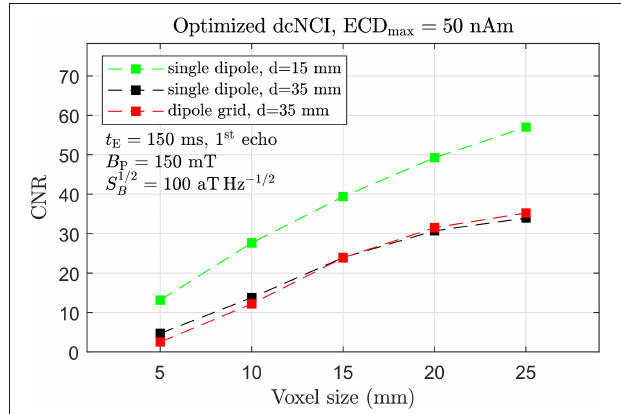
FIGURE 10 | Projected CNR for optimized dcNCI of the MEG-derived sustained activity with an ECD max of 50 nAm taking t E = 150 ms (1 st echo), B P = 150 mT, and S 1 / 2 B = 100 aTHz − 1 / 2 . Signal reduction by 0.706 due to reduced spin density was taken into